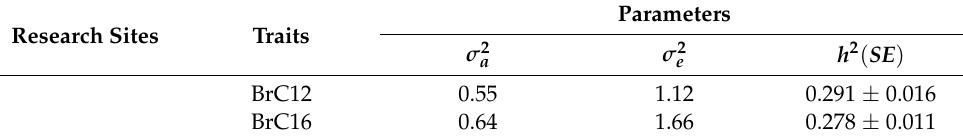
Table 1. Cont. Research